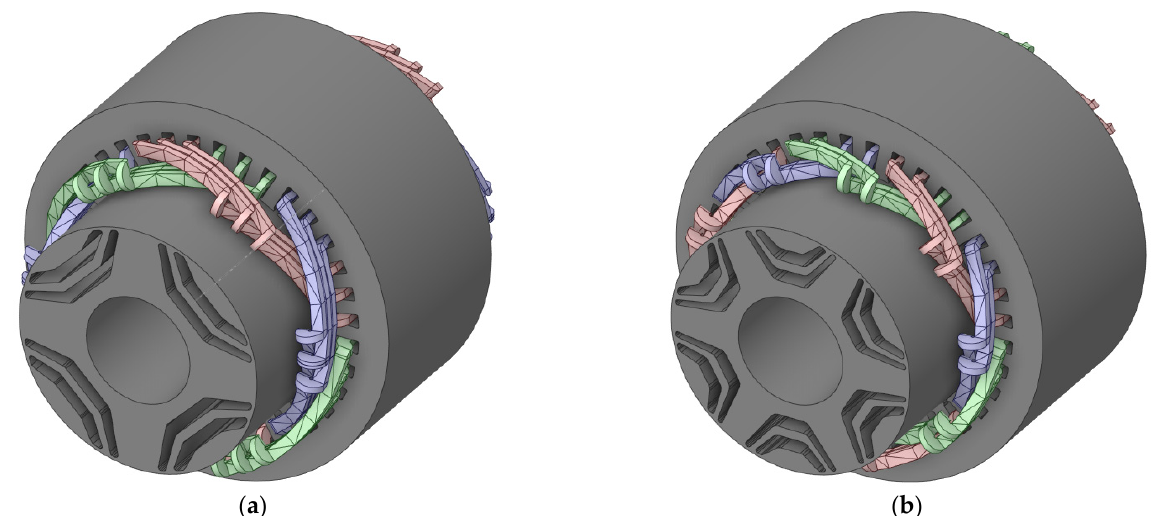
Figure 3. Three-dimensional schematics of ( a ) four-pole synchronous reluctance motor with two barriers per pole; and ( b ) six-pole synchronous reluctance motor with two barriers per pole. Three- phase stator windings are highlighted in red, green, and blue, corresponding to each phase. Rotor in both machines is shown as an exploded view.